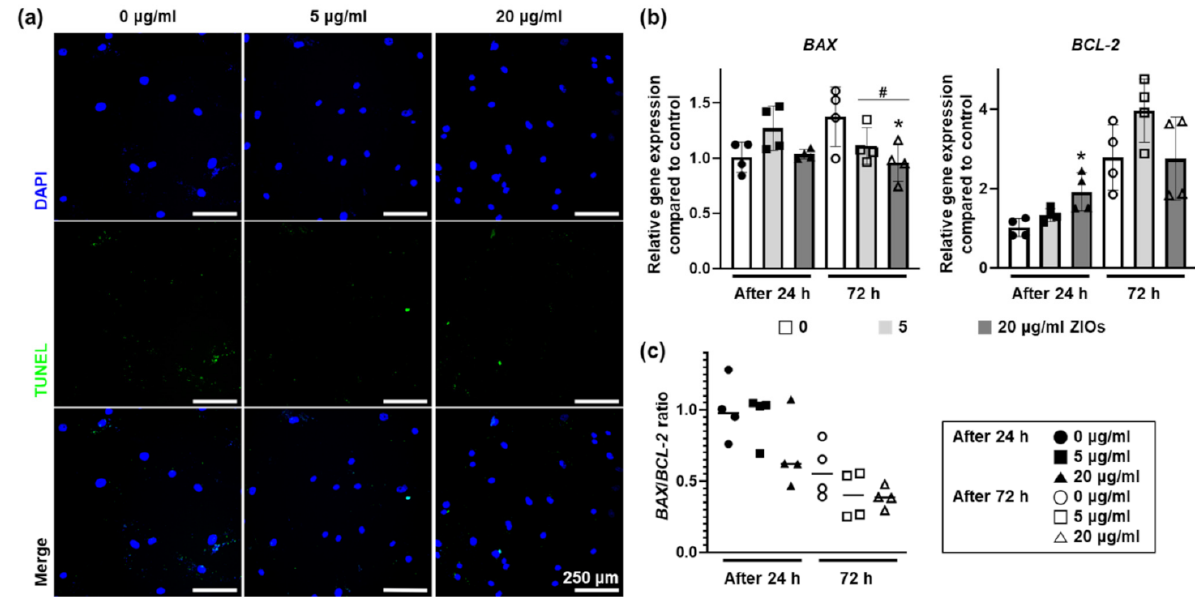
Figure 3. Effects of ZIOs on hMSCs viability. The cellular viability of the hMSCs treated with the ZIOs as evaluated by ( a ) TUNEL staining (72 h, green indicates dead cells, blue indicates nuclear, scale bars indicate 250 µ m) and ( b ) pro-apoptotic ( BAX ) and anti-apoptotic ( BCL-2 ) gene expression at 24 and 72 h (* p < 0.05, compared to the 0 µ g/mL group, # p < 0.05, compared to each group). ( c ) BAX/BCL-2 ratio in hMSCs at 24 and 72 h after the ZIOs